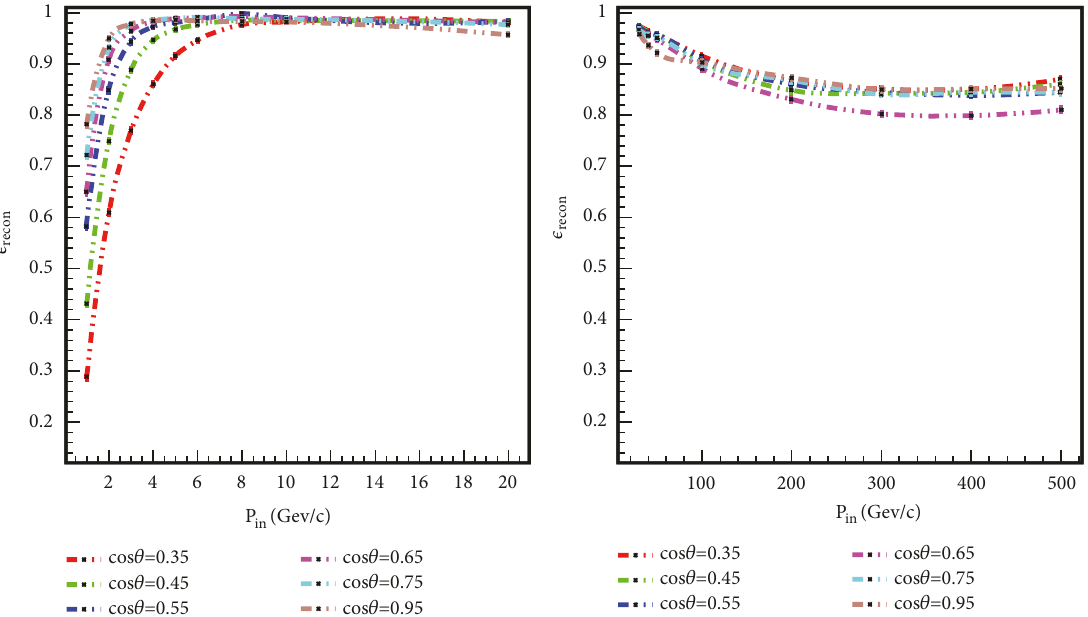
Figure 4: Muon momentum reconstruction efficiency as a function of the input momentum for different zenith angles. The left panel refers to low energy, 1 ≤ P 𝑖𝑛 ≤ 20GeV muons, while the right panel refers to the high energy, 20 ≤ P 𝑖𝑛 ≤ 500 GeV muons.